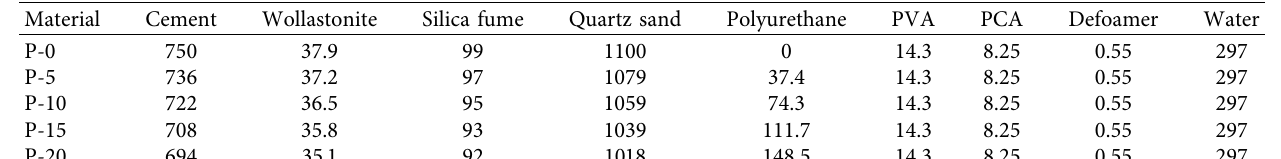
Table 2: Mix ratio of polyurethane-PVA fiber cement mortar (kg/m 3 ).